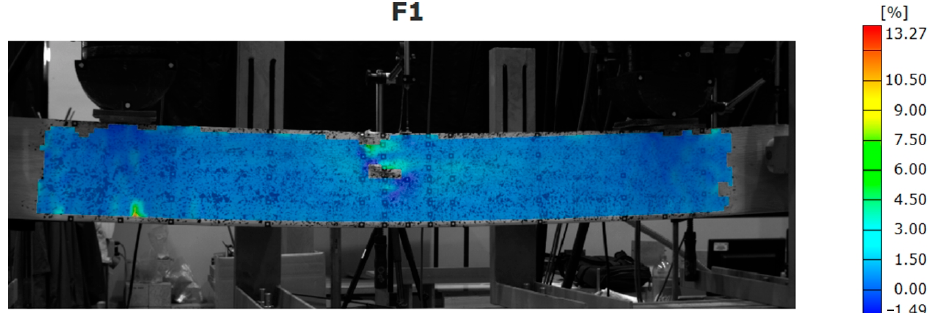
Figure 16. Map of strain distribution for beam strengthened with CFRP laminate bonded to the bottom